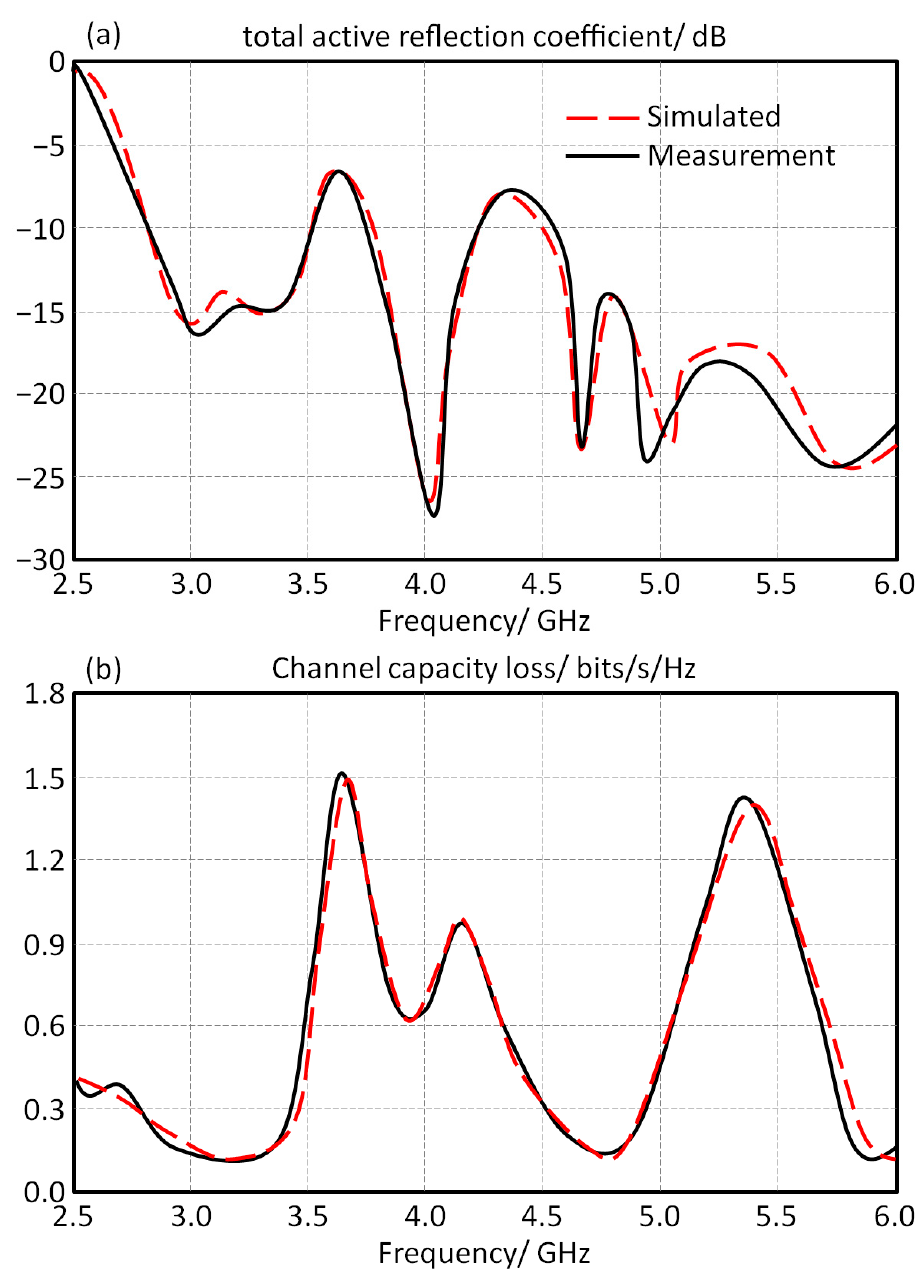
Figure 10. Antenna array performance in terms of channel response: ( a ) total active reflection coefficient and ( b ) channel capacity loss.